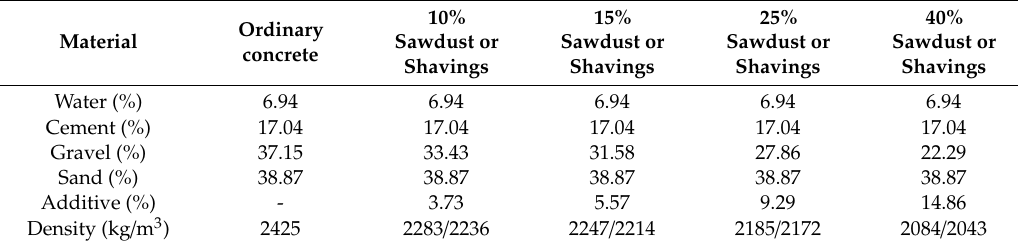
Table 2. Dosages used in concrete blocks fabrication.